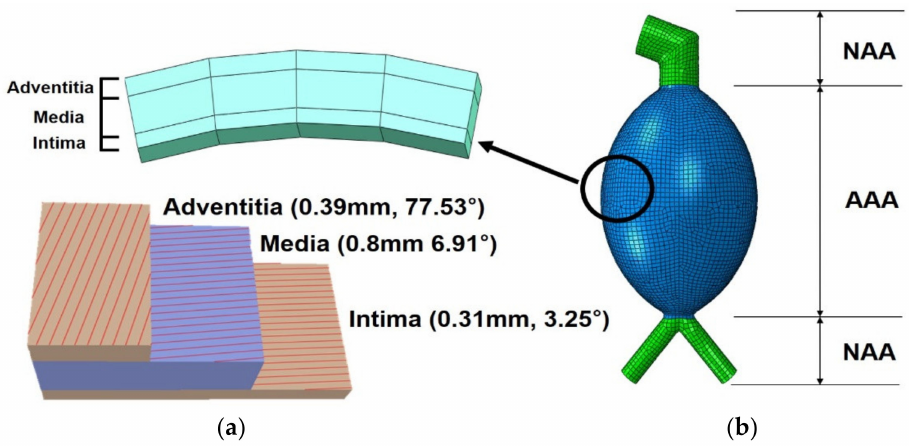
Figure 3. ( a ) Fiber orientation and ( b ) normal aorta and aneurysm region.